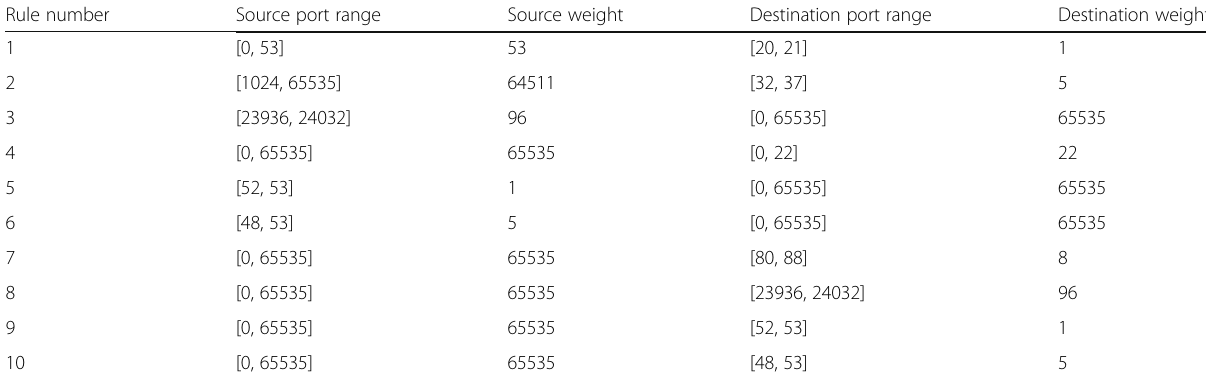
Table 2 The decimal values of the range of source and destination ports along with their weights Rule number